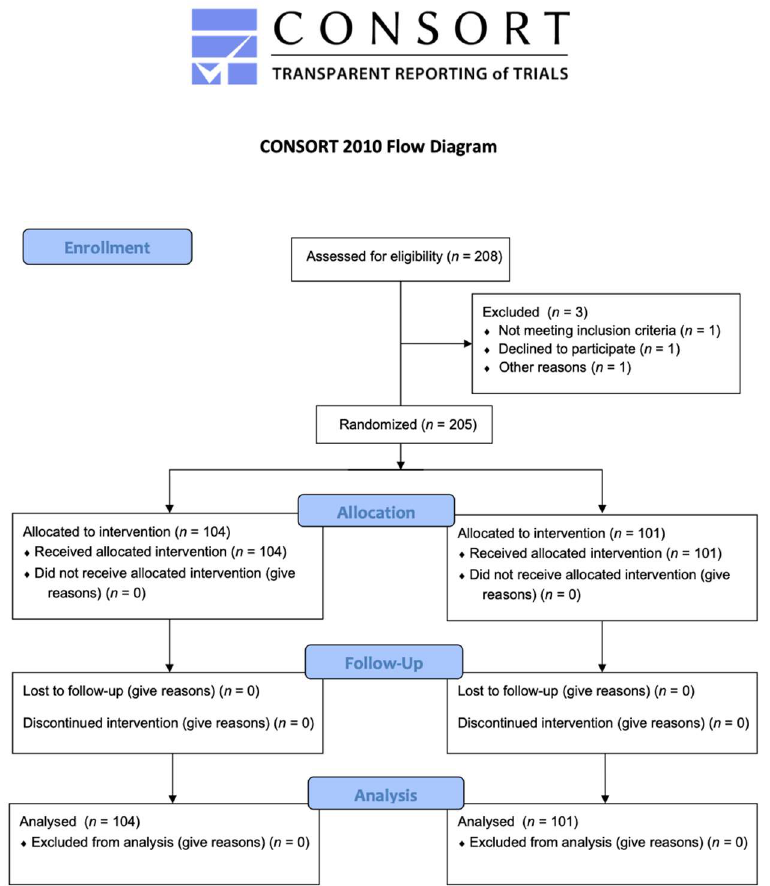
Figure 1. Consort flow chart of the selection process of the patients studied. IoL—induction of labour, PROM—premature rupture of membranes.